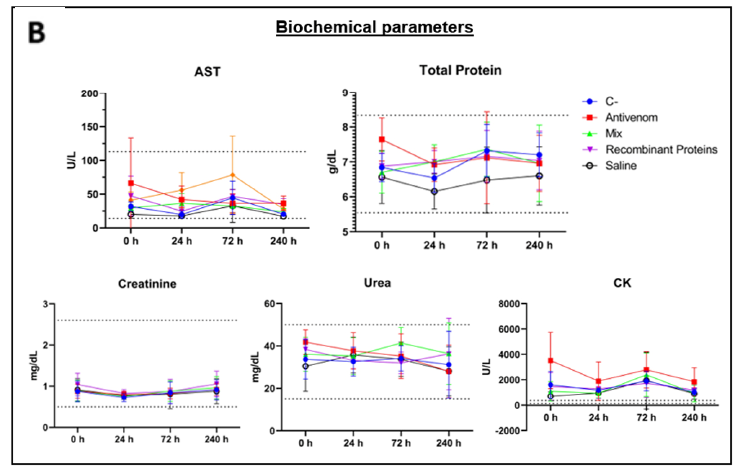
Figure 8. Monitoring of blood parameters of rabbits submitted to the neutralization test in the ear pinna. Hematological ( A ) and biochemical ( B ) parameters were verified from blood samples collected in different time courses (X axis). C-: C serum. Antivenom: AV serum. Mix: MIX serum. Rec: REC serum. Saline: Inoculation of saline instead of venom. AST: aspartate aminotransferase. CK: muscular creatine kinase. Lymphocytes: relative lymphocyte count. Heterophiles: relative heterophile count. The dashed lines indicate upper and lower reference values. For all parameters analyzed, no significant differences were found among the control groups (C and Saline) and AV, REC, and MIX